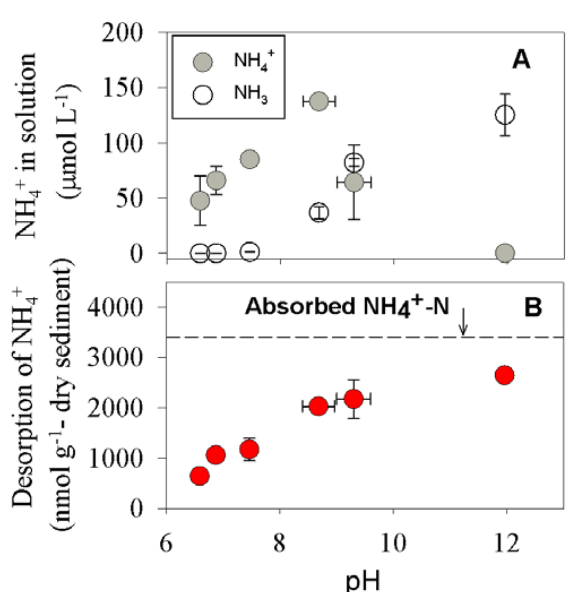
Figure 3. Experimental pH effects on NH 4+ concentration in solution (A) and desorption of 3 exchangeable NH 4+ (B), using the 0-2 cm homogenized sediments from Budds Landing collected 4 in November 2008. Dissolved NH 5 concentrations and pH in the aquatic phase (Eq. 2). Desorbed NH 4+ was the sum of ∑ NH water and the volatilized NH Table 3). The dashed line represents ‘total’ absorbed NH 4+ , estimated by KCl extraction of pH-8 neutral sediment (Eq. 5). The vertical and horizontal error bars are the standard errors of 9 ammonium and the pHs, respectively. 10